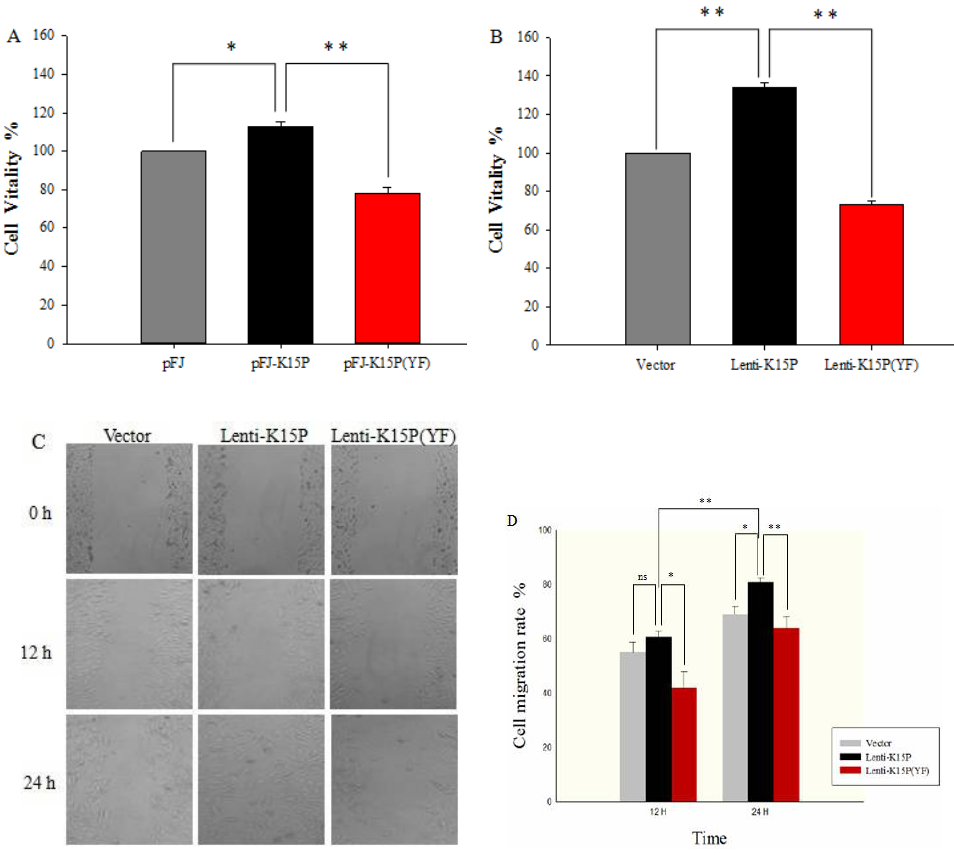
Figure 3. Cell proliferation and migration determined by CCK-8 assays and wound scratch assays. ( A ) Percentage cell viability with different treatments in HEK-293T cells. ( B ) Percentage cell viability with different treatments in EA.hy926 cells. ( C ) Representative photographs of migratory cells were captured at three times point after scratching (100 × ). ( D ) The right panel shows that cell migration was quantified by measuring the maximum migration distance with different treatments at indicated times in EA.hy926 cells. Data are presented as the mean ± standard error. n = 3 per group (the n refers to technical replicates). ns, not significant. ** p < 0.01, * p < 0.05.